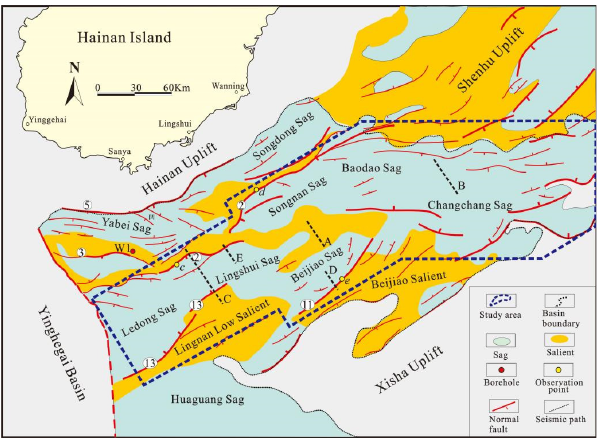
Figure 1. The location and structural divisions of the QDN Basin. Points b , d , and e , and black dashed lines A, B, C, D, and E are the research locations used in the following figures. Table 1. The Paleogene stratigraphy and sedimentary environment of the QDN Basin. Stratigraphy